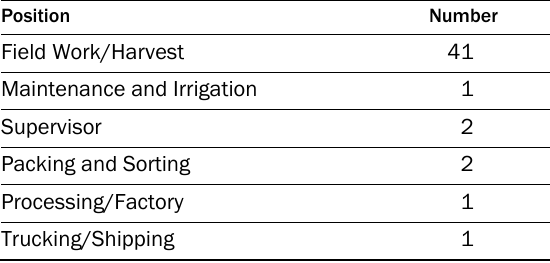
Table 2. Most Recent Workforce